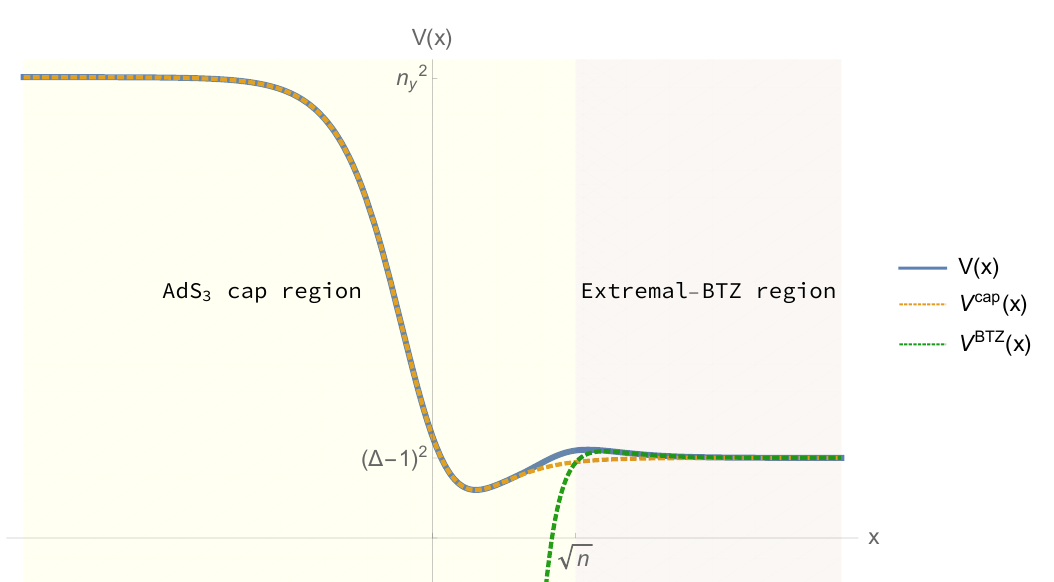
Figure 9: The centrifugal-barrier regime: the superstratum potential V ( x ) and the approximated potential V BTZ ( x ) when 2